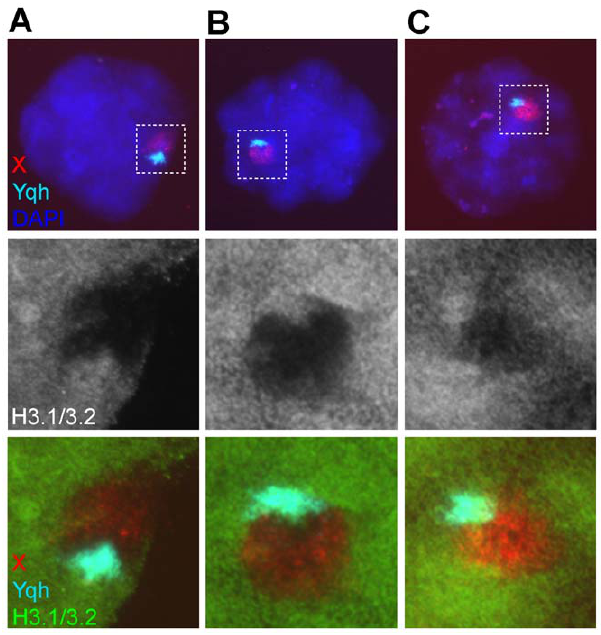
Figure 2. Differential H3.1/3.2 nucleosome remodelling be- tween Yq heterochromatin and the X chromosome in late pachytene spermatocytes. A Late pachytene nucleus showing a high degree of nucleosome remodelling for the X chromosome, but no remodelling for Yqh. B Late pachytene nucleus showing an interme- diate degree of nucleosome remodelling for the X chromosome, but no remodelling for Yqh. C Late pachytene nucleus showing a low degree of nucleosome remodelling for the X chromosome, but no remodelling for the Yqh.